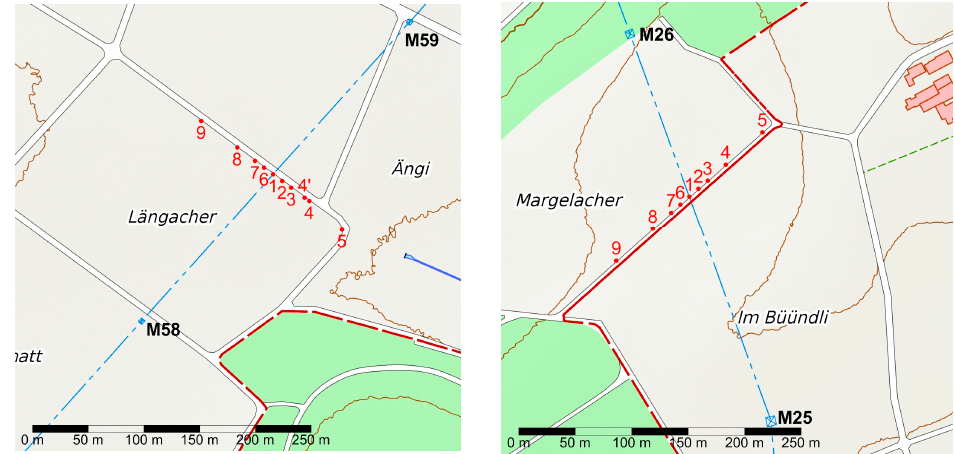
Figure 7. Measurement sites in Iffwil ( left ) and Wiler ( right ). The blue dash ‐ dotted line marks the power line axis between the towers; the nearest towers are marked M58/M59 and M25/M26, respectively. The red points mark the measurement points, numbered 1 to 9. Measurement point 1 is below the line axis, points 2 to 5 are on one side, and 6 to 9 on the other side of the axis. The red lines mark boundaries between municipalities. Background map data AV, © Swisstopo.